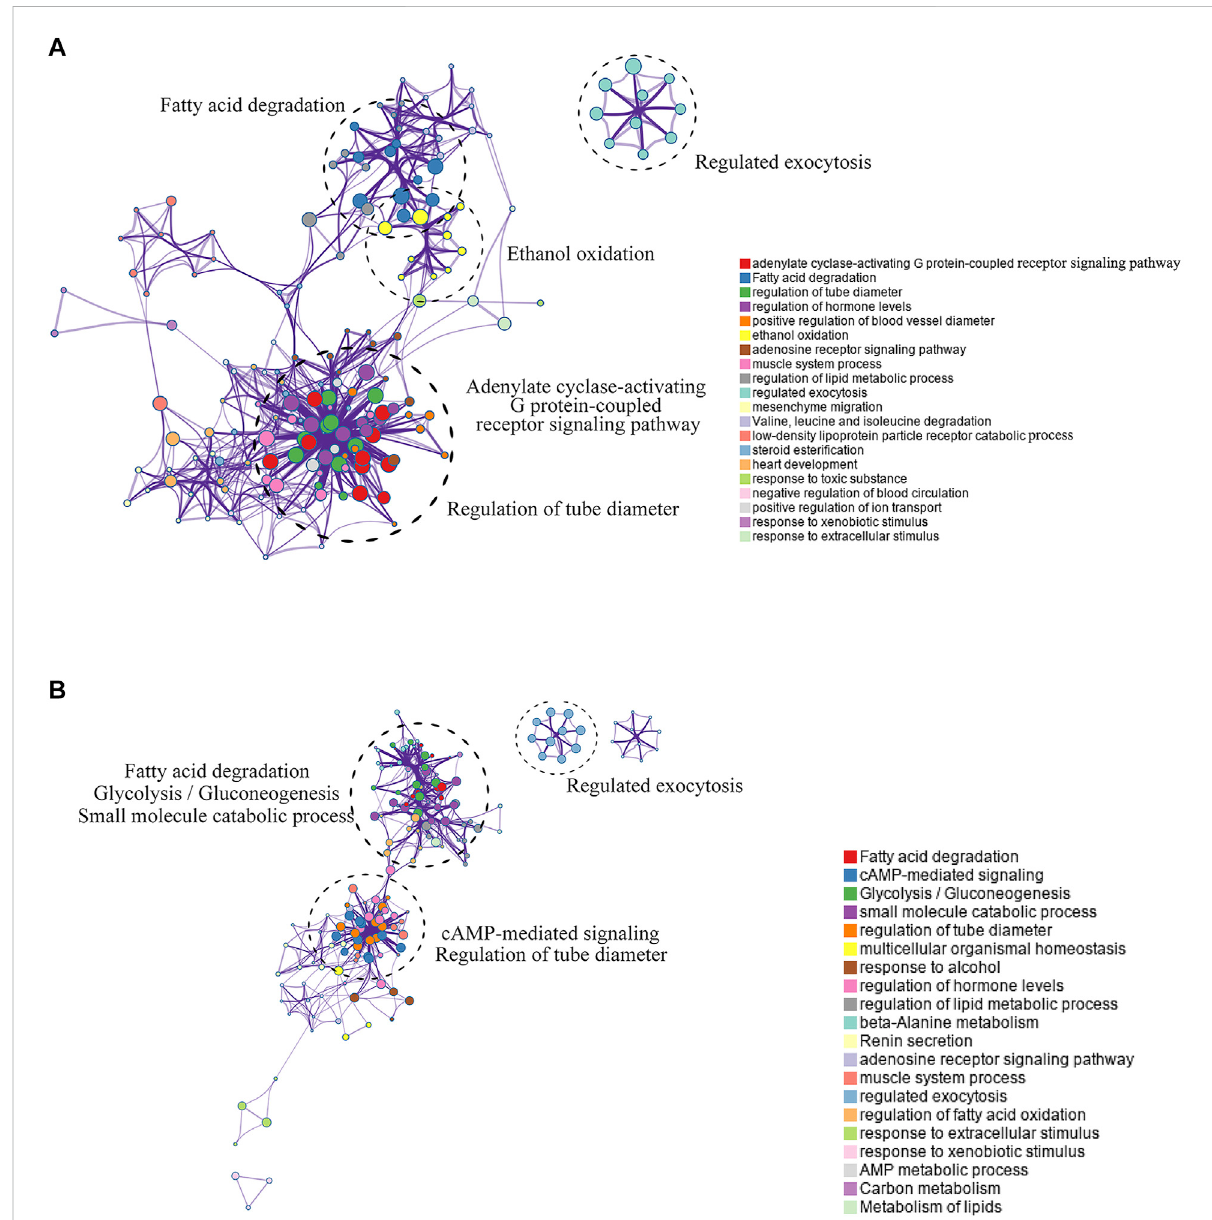
FIGURE 3 Pathway enrichment analysis of mrDEGs in LUAD. (A) The pathway enrichment analysis of the upregulated mrDEGs. Each node represents a gene group. The node size is proportional to the total number of genes in each gene set. The width of the line between nodes represents the proportion of genes shared among gene sets. (B) The pathway enrichment analysis of the downregulated